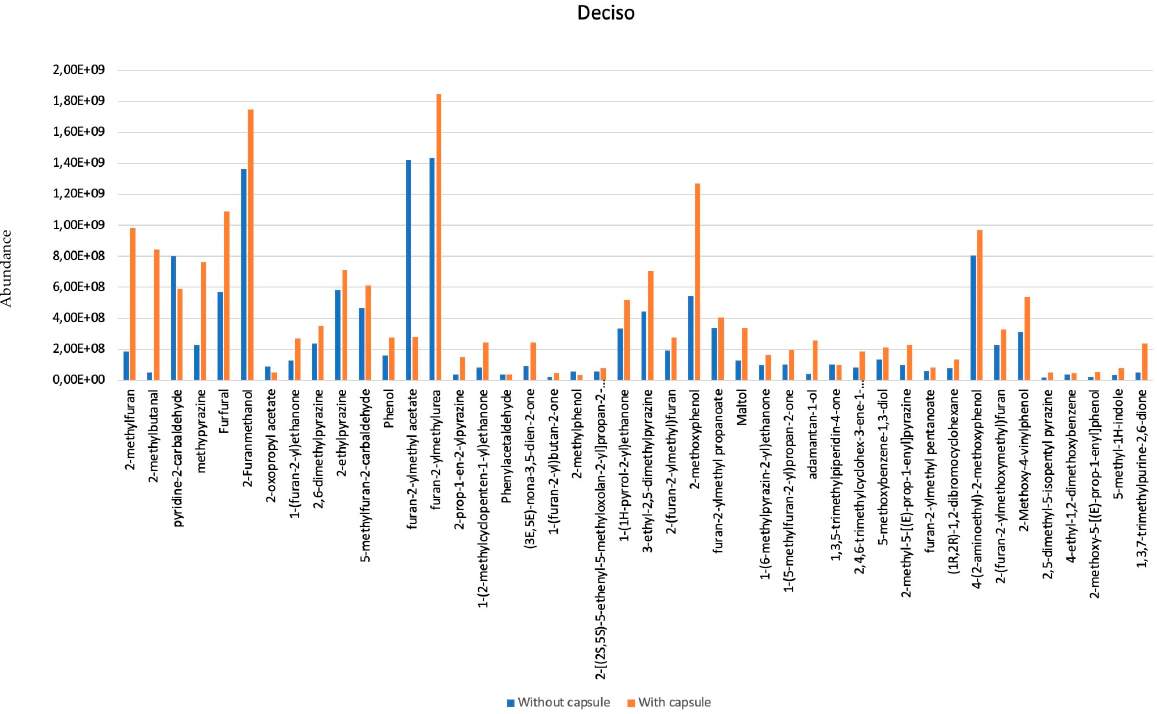
Figure 1. Comparison abundance value of common compound between Biologico coffee “with capsule” and “without capsule”.